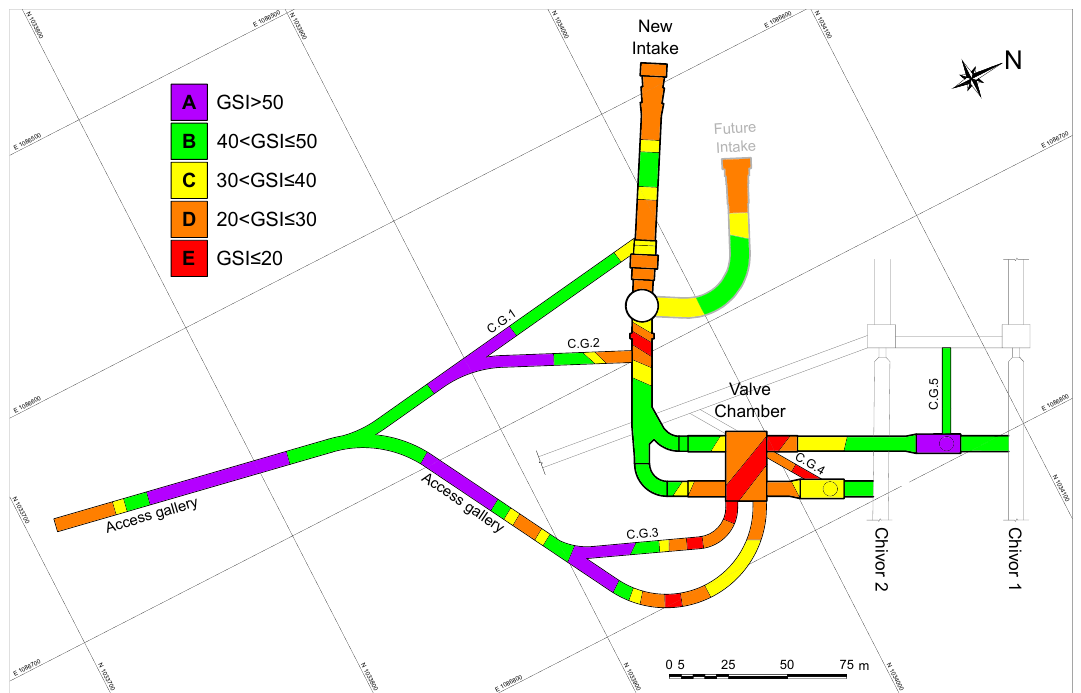
Figure 5. Chivor’s Life Extension Project (CLEP) initial geological characterization. Rocky mass estimation for underground structures.